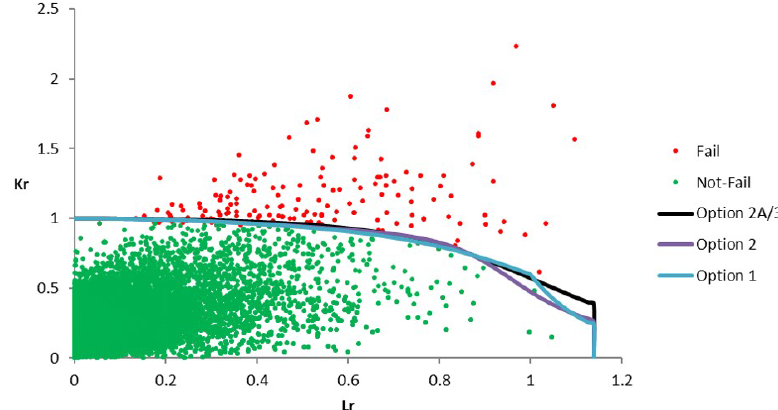
Figure 12. Probabilistic fracture assessment using the Monte Carlo method and based on FAD (Amirafshari,